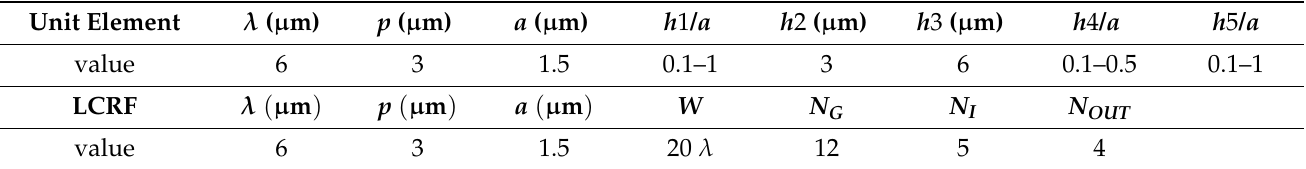
Table 1. Geometric parameters for design.